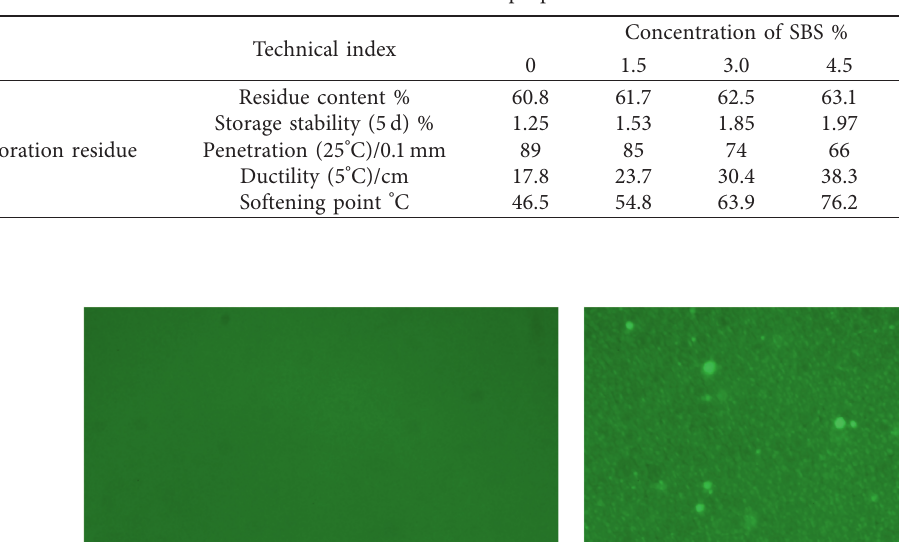
Figure 8: Microstructure of concentrated SBS latex with different T/S ratios: (a) 2.5 :1, (b) 2.0:1, and (c) 1.5:1 (magnification: × 400). Table 7: Conventional properties of the various